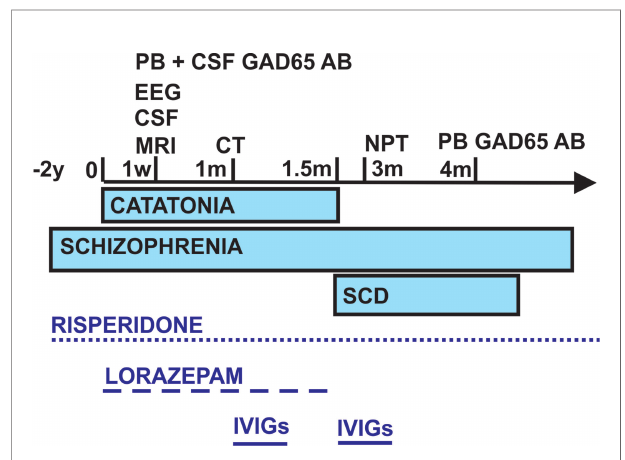
FIGURE 1 | Schematic overview of the time course regarding symptom presentation, diagnostics, and treatment. CSF, cerebrospinal fl uid; EEG, electroencephalography; GAD65 AB, glutamic acid decarboxylase autoantibodies; IVIGs, intravenous immunoglobulins; m, month; NPT, neuropsychological testing; PB, peripheral blood; SCD, subjective cognitive decline; w, week; y,